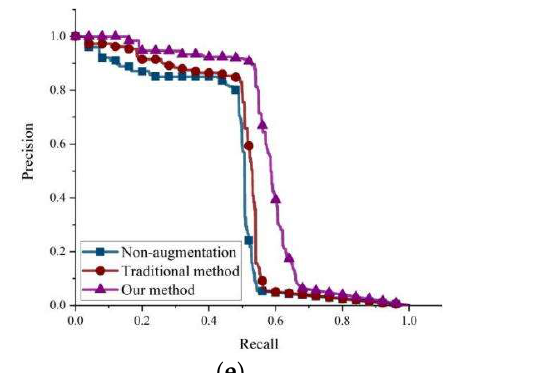
Figure 17. Comparison of PR curves. ( a ) all; ( b ) coal; ( c ) gangue; ( d ) bag; ( e ) iron; ( f ) wood.